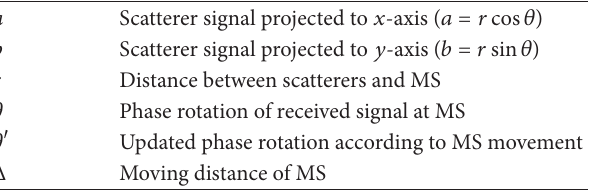
Table 1: 2D scatterer model parameters.